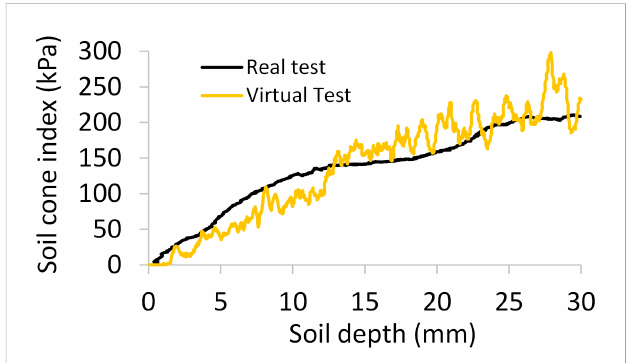
FIGURE 9 Comparisons of the simulated and measured curves of soil cone index-depth; averaged over three